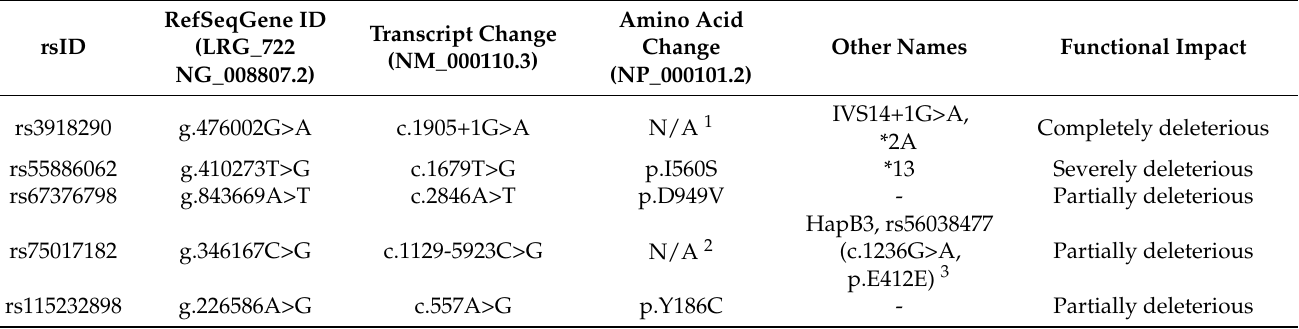
Table 1. Reference information for commonly tested DPYD variants associated with DPD deficiency and increased risk of severe 5-FU